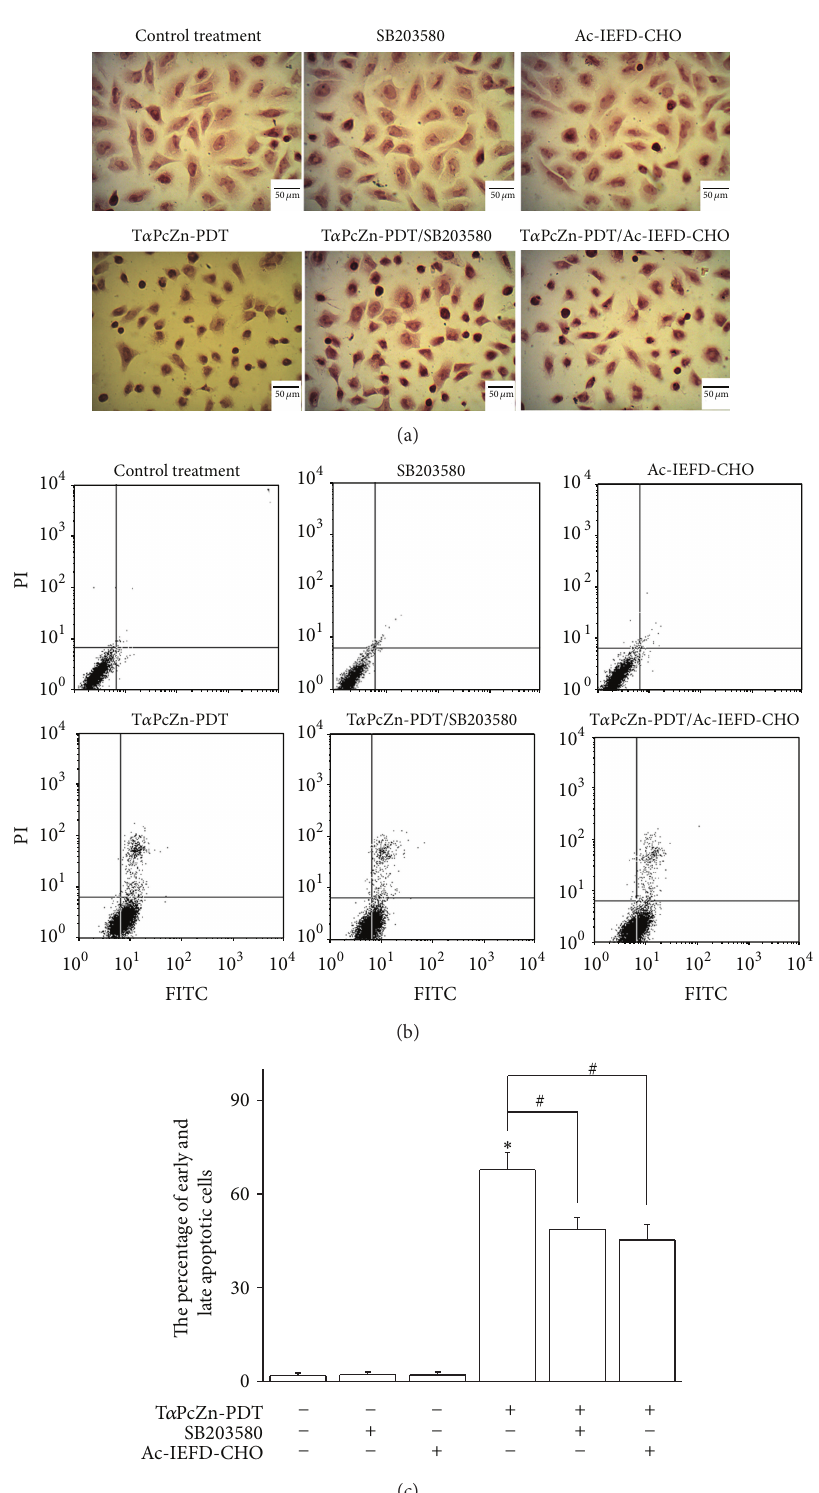
Figure 3: Effect of T 𝛼 PcZn-PDT on apoptosis of Bel-7402 cells in the absence or presence of SB203580 or Ac-IEFD-CHO. Bel-7402 cells were pretreated with T 𝛼 PcZn (54 𝜇 M) in the absence or presence of SB203580 (10 𝜇 M) or Ac-IEFD-CHO (10 𝜇 M) for 2.5 h, exposed to red- light irradiation (53.7 J/cm 2 ), and then incubated for 3h. The morphology of apoptotic cells was analyzed by HE staining assay (a), and the percentage of apoptotic cells was assayed by flow cytometry analysis of annexin V-FITC/PI double stained cells (b and c). Bars under each panel represent 50 𝜇 m. Values presented are representative of three independent experiments (means ± S.D.; ∗ 𝑃 < 0.05 , compared with control treatment; # 𝑃 < 0.05 , compared with T 𝛼 PcZn-PDT